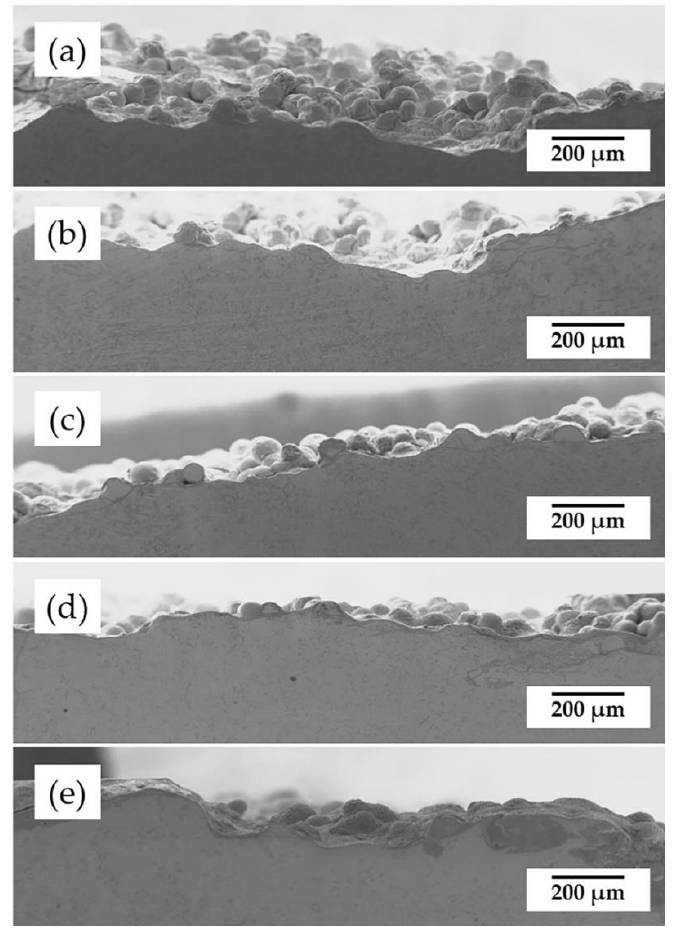
Figure 4. Surface morphology of the coatings before and after annealing treatment: ( a ) before annealing; ( b ) 450 °C for 2 h; ( c ) 650 °C for 2 h; ( d ) 850 °C for 0.5 h; ( e ) 850 °C for 2 h.